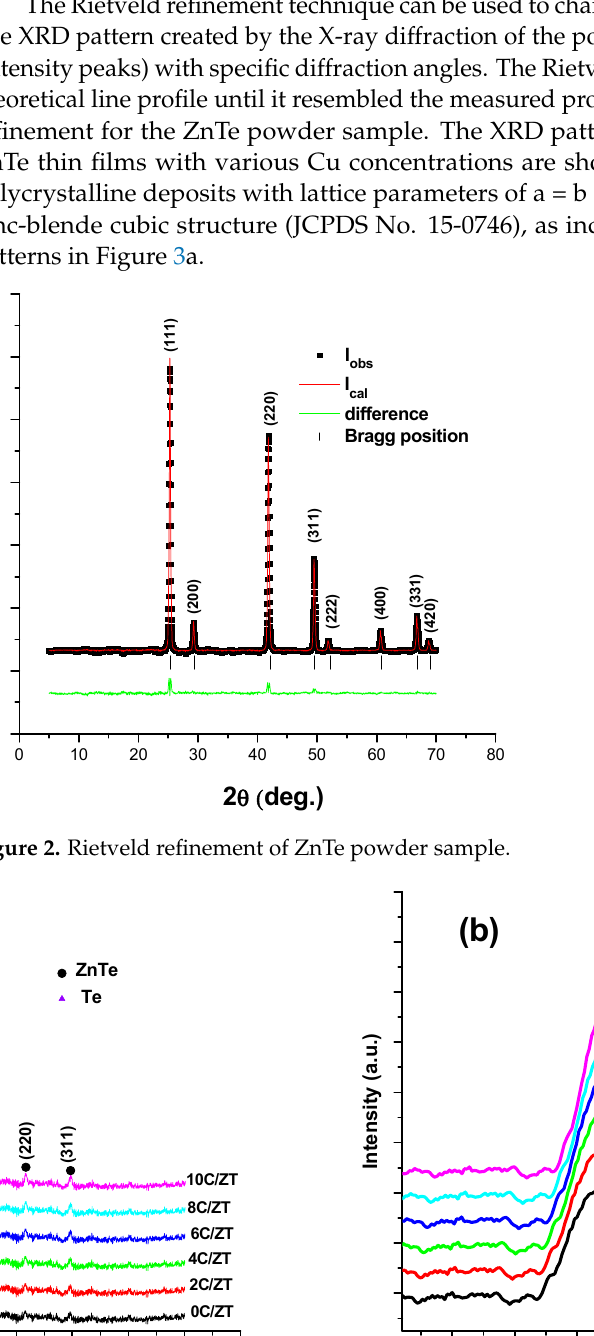
Figure 1. EDAX of ( a ) ZnTe and ( b ) Zn 0.98 Cu 0.02 Te thin films.